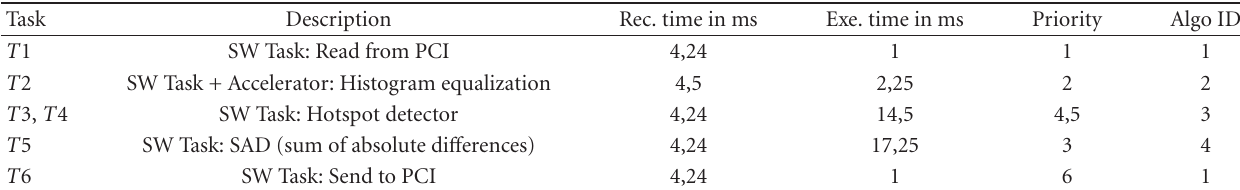
Table 7: Detailed information about each task of the TG 2 at 100 MHz.